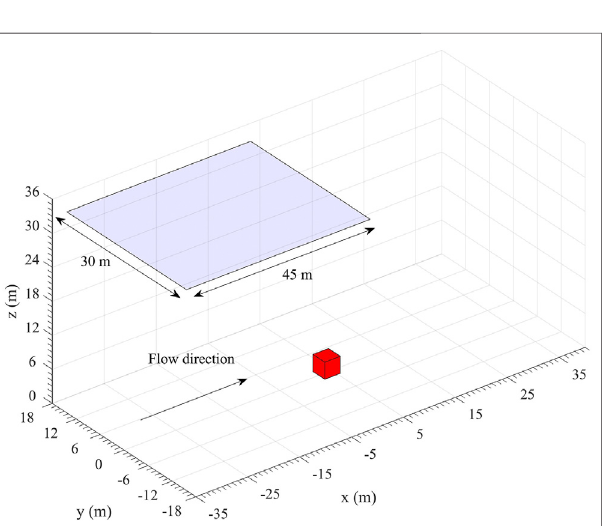
FIGURE 7 | Computational con fi guration in the fi rebrand deposition study with a structure 3 × 3 × 3m. The horizontal plane located at z (cid:3) 35m is where the fi rebrands are released